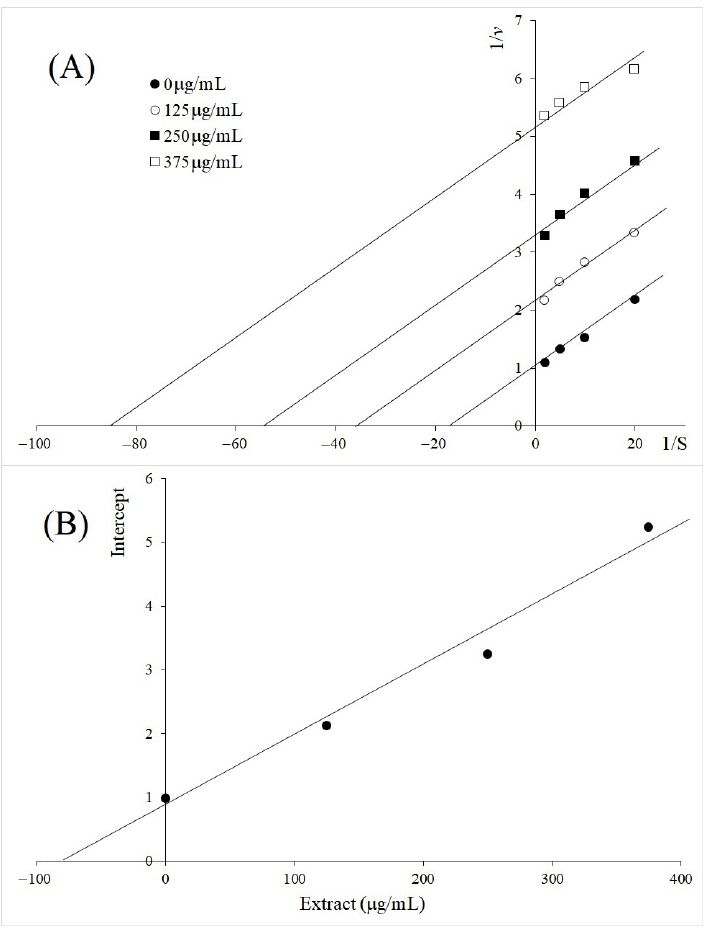
Figure 5. Inhibition kinetics of M. oleifera on TYR diphenolase activity at different concentrations (125, 250, and 375 µg/mL). ( A ) Lineweaver–Burk plot; ( B ) secondary plot between inhibitor con- centrations and intercept (linear equation; y = 0.01112x + 0.8113, R 2 = 0.9772). 250, and 375 µ g/mL). ( A ) Lineweaver–Burk plot; ( B ) secondary plot between inhibitor concentrations and intercept (linear equation; y = 0.01112x + 0.8113, R 2 =